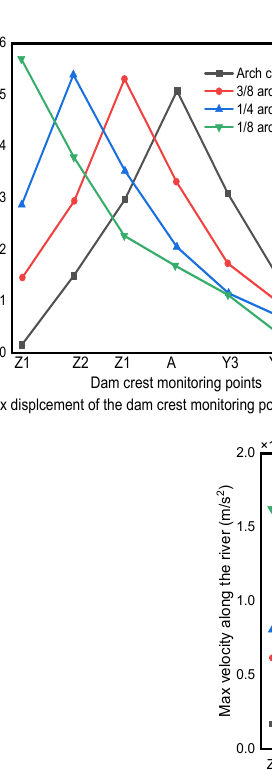
Arc length (m) At arch crown beam 3/8 arch 1/4 arch 1/8 arch Figure 20. Dam crest damage curve for various horizontal blast positions. The maximum values of displacement, velocity, and acceleration in the full dynamic time history of each monitoring point at the dam crest are extracted to further investigate the dynamic response of the dam body under different initiation positions, as shown in Figure 21. As shown in Figure 21, as the initiation center moves from the arch crown can- tilever to the side arch end, the maximum value of displacement, velocity, and accelera- tion at the dam top also moves from the arch crown cantilever to the side dam end. When the detonation center is near the arch crown cantilever, i.e., near point A, the maximum value of displacement, velocity, and acceleration of each monitoring point on the dam